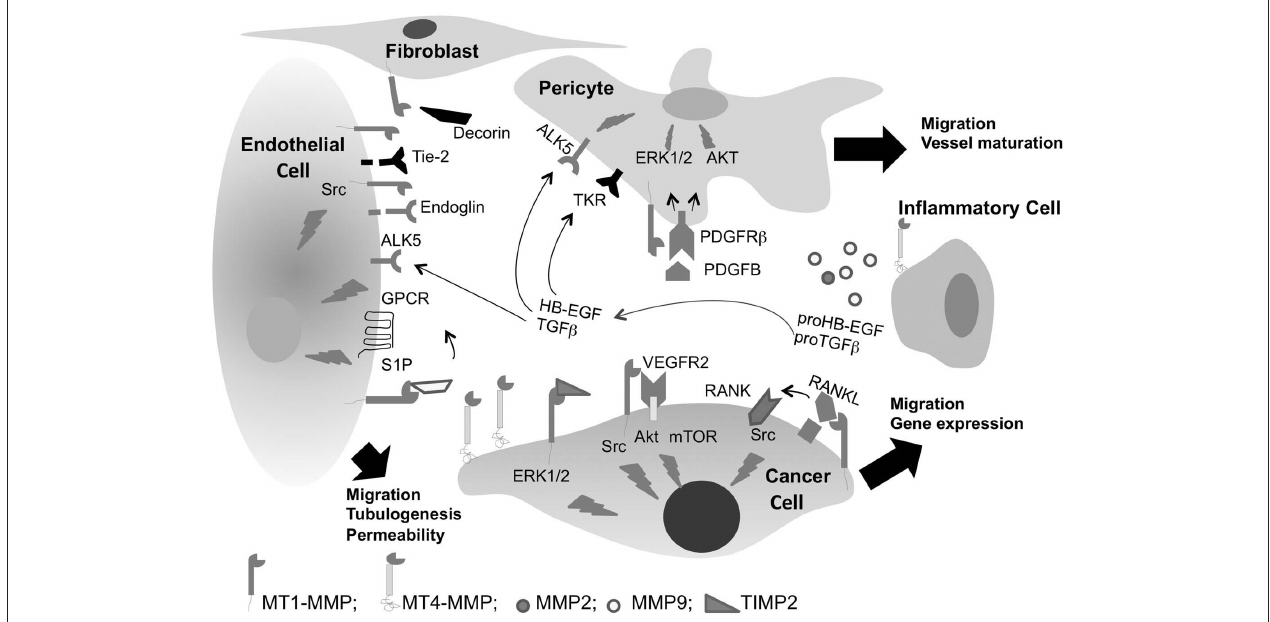
Figure 2 | Membrane type-MMPs regulate vascular cell signaling in cancer. MT1-MMP regulates cell migration through both ECM proteolysis and non-proteolytic-dependent TIMP-2 activation of ERK1/2 pathway. MT1-MMP regulates VEGF gene expression through Src, Akt, and mTOR activation and stimulates tumor angiogenesis. In addition, it induces RANKL shedding and signaling through Src leading to cell migration. MT1-MMP cooperates with platelet derived S1P to induce signaling through G protein-coupled-receptors (GPCRs) and regulates endothelial cell migration and